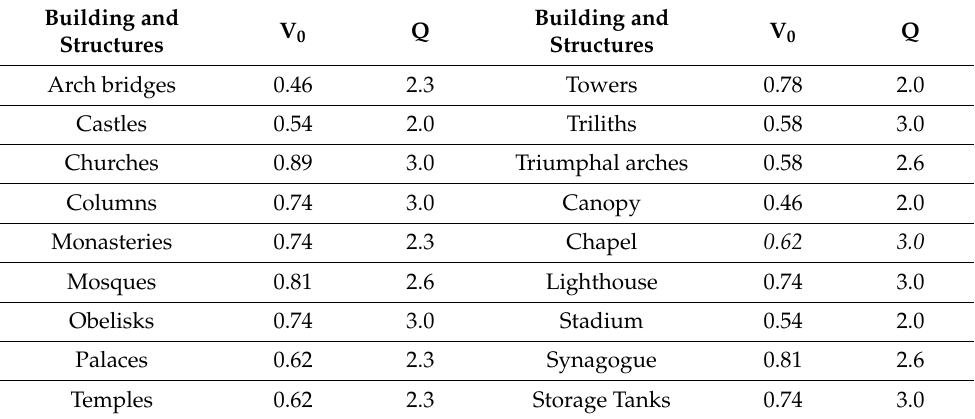
Table 3. Typological vulnerability V and ductility Q indexes for ARCH building and